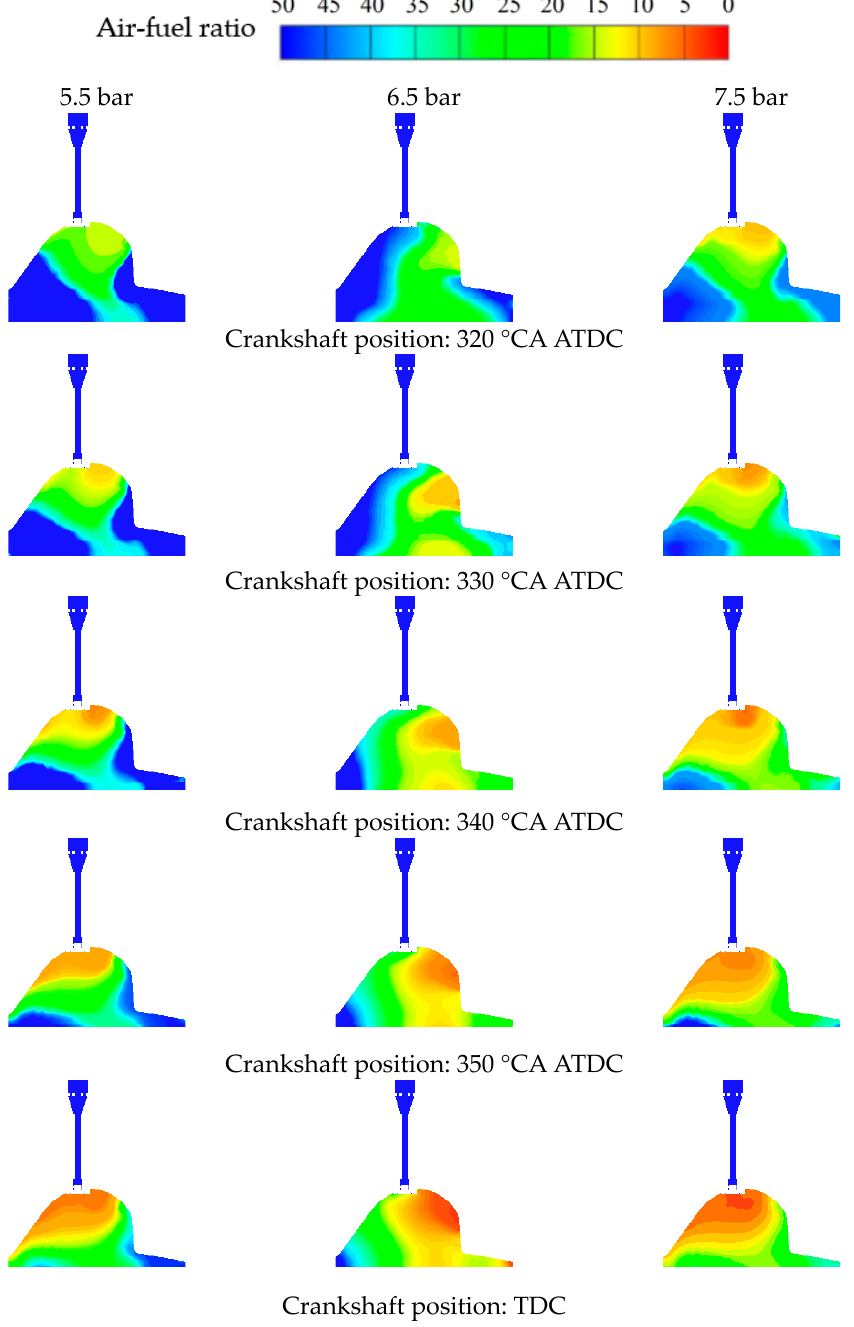
Figure 10. Distribution of mixture concentration in-cylinder at different injection pressures.